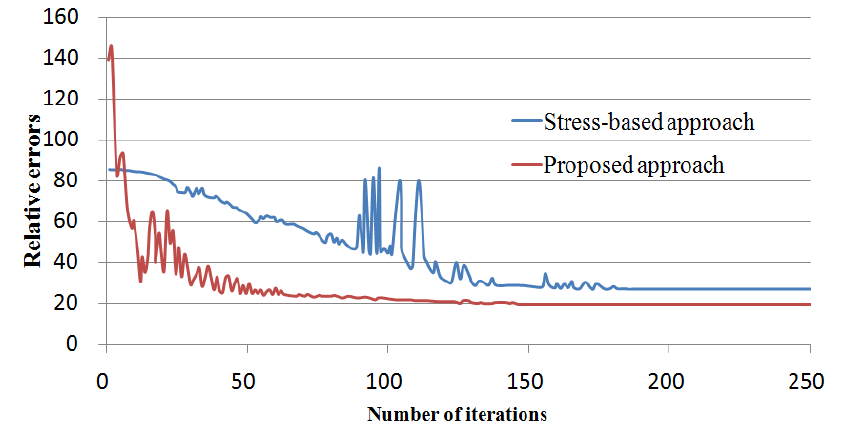
Figure 9. Optimization processes using the stress-based and proposed approaches.